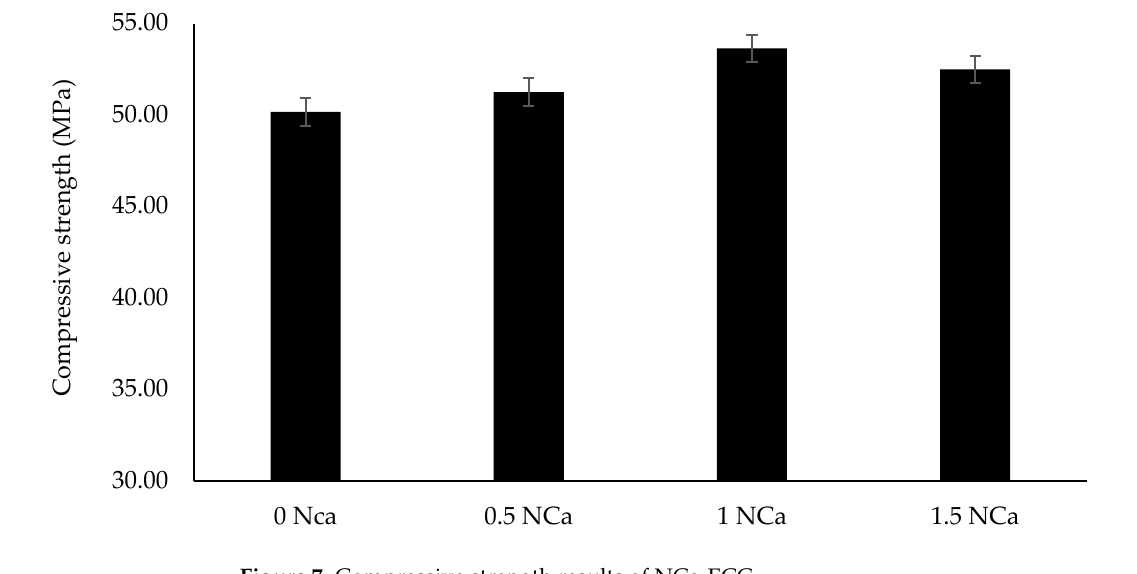
Figure 7. Compressive strength results of NCa-ECC.